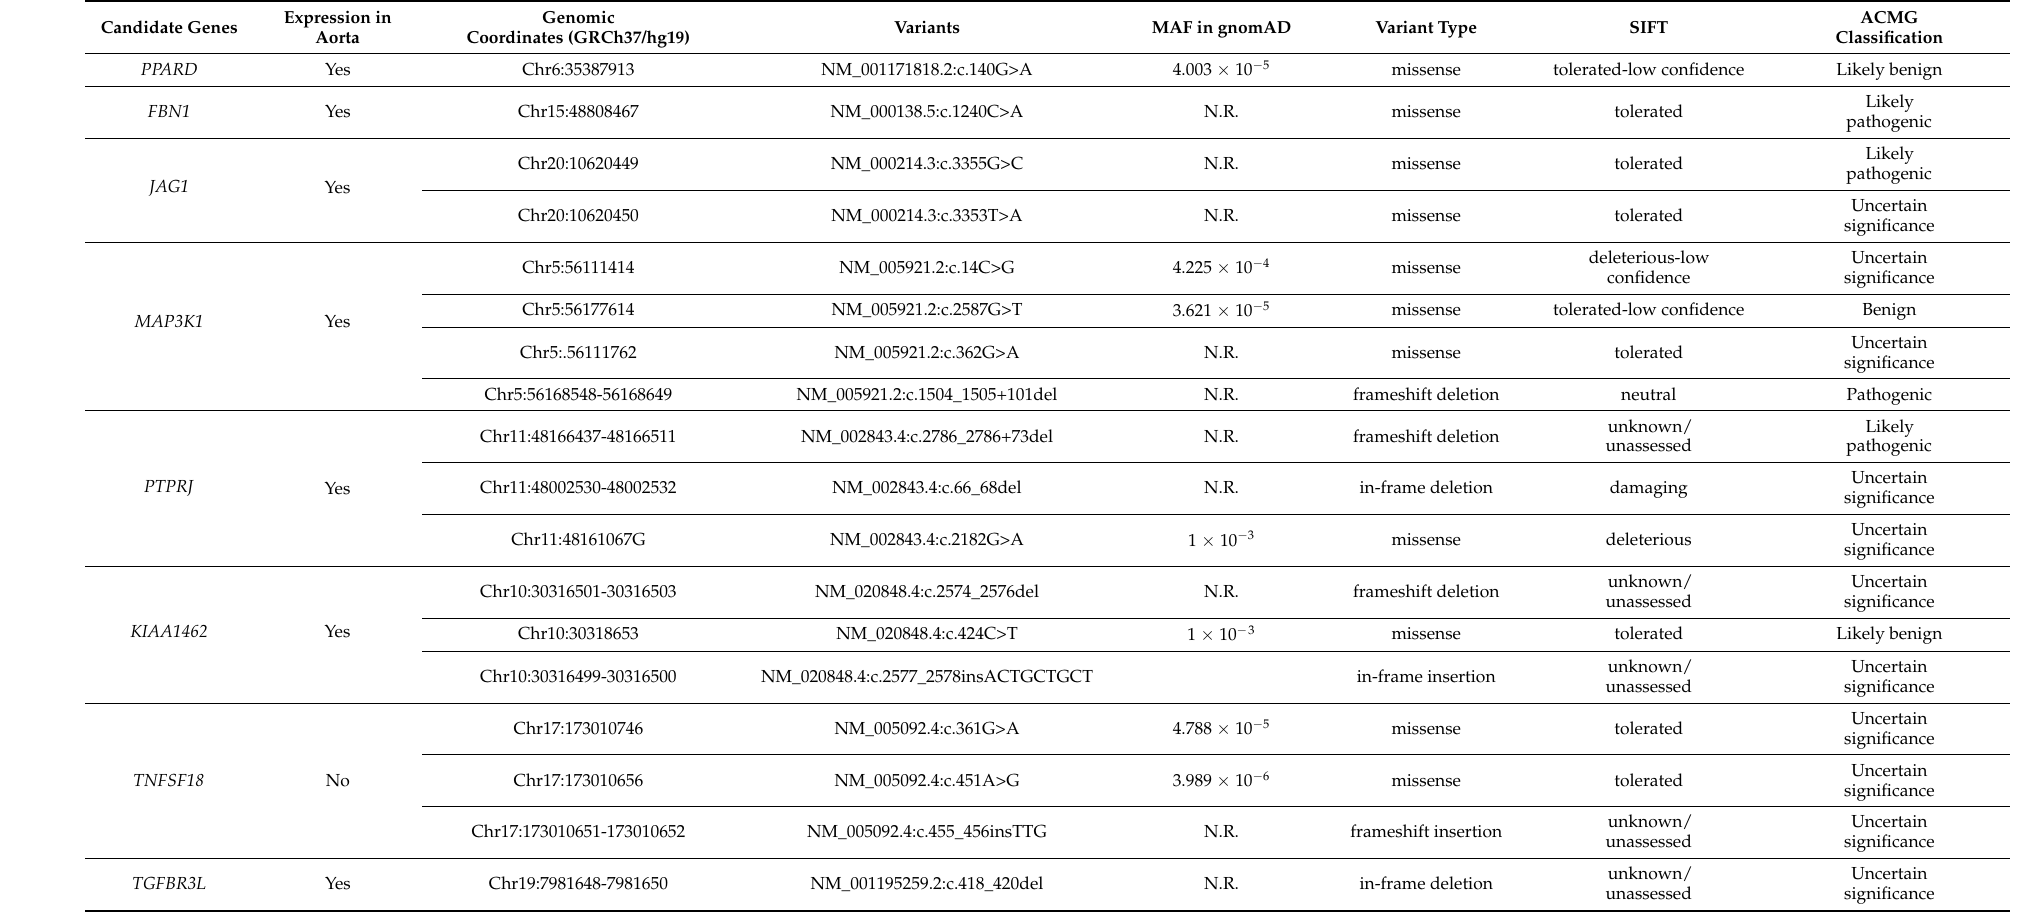
Table 4. Genetic variants in candidate genes selected under different VAAST analysis